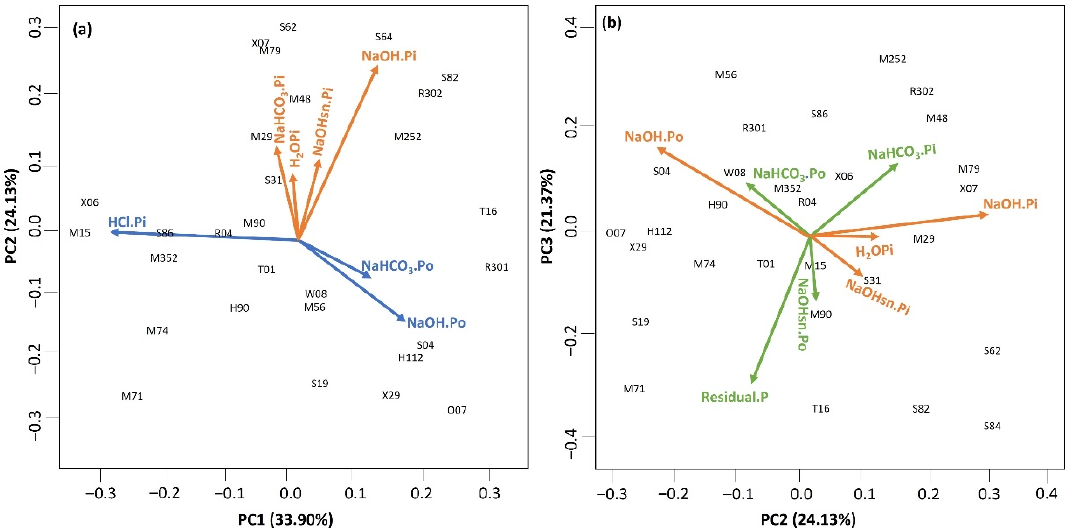
Figure 2. Principal component analysis (PCA) biplots of the significant ( p < 0.05) phosphorus (P) fractions distribution across the 29 Irish grassland soils. Individual grassland sites are marked with an individual code (e.g., M74). Soil properties for each site are presented in the Supplementary Material Table S1. Plot ( a ) represents the significant ( p < 0.05) P fractions (arrows) for the sites distribution in the principal component (PC) 1 (blue) and 2 (orange); Plot ( b ) represents the significant ( p < 0.05) P fractions (arrows) in the PC 2 (orange) and 3 (green). PC loadings are presented in the Supplementary Material Table S2. Table 3. Percentage of constrained and unconstrained variance in the redundancy detrended anal- ysis (RDA). Numbers in brackets correspond to the RDA loadings. Bold numbers represent a signif- icant ( p < 0.05) correlation coefficient (r).